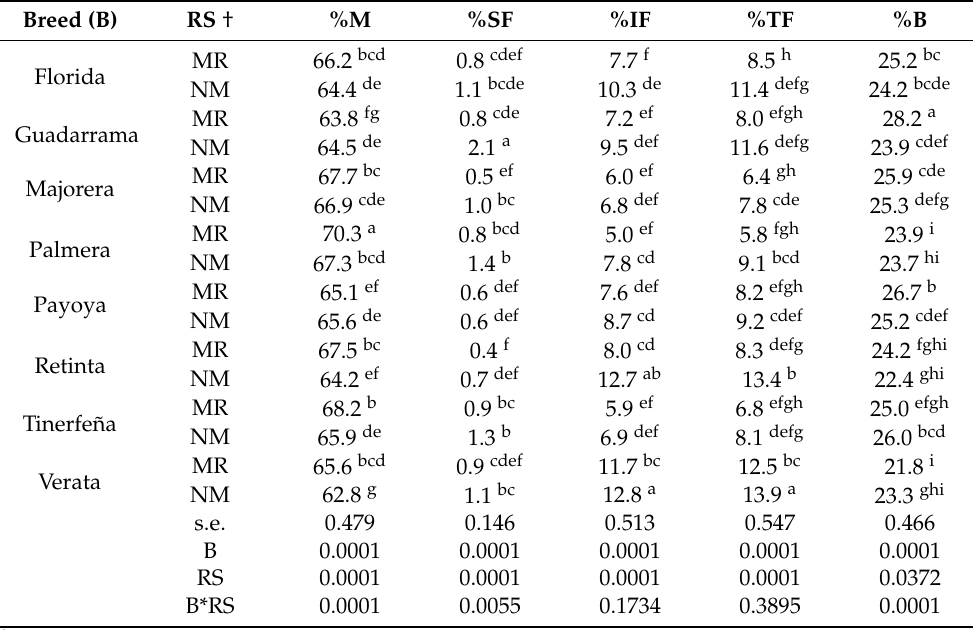
Table 3. Means and standard errors for forelimb tissue composition from kids reared with milk replacer (MR) or natural milk from their dams